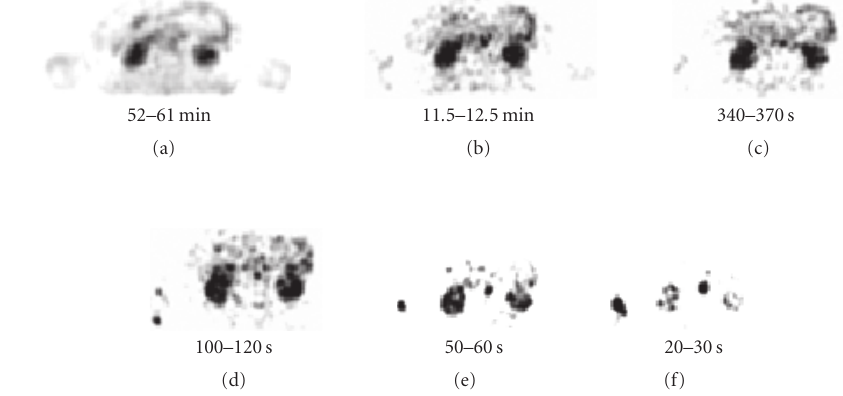
Figure 2: Some of the sequential transaxial images of one study.